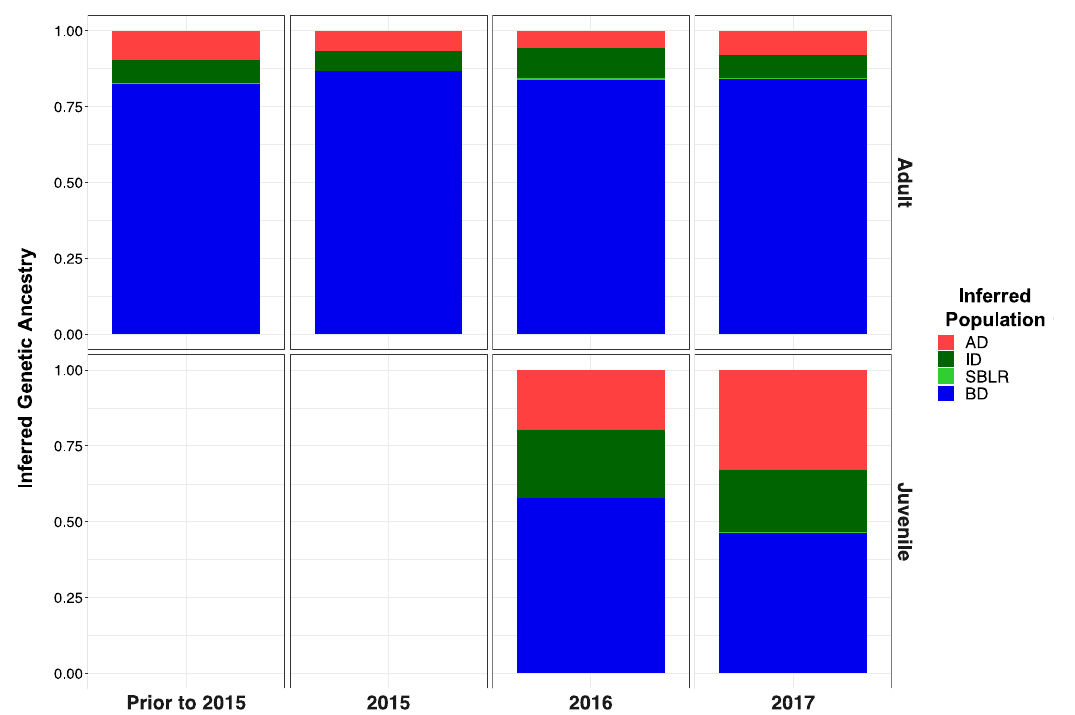
Figure 5. Inferred proportion of genetic ancestry from each of the four reference populations across recolonizing adult steelhead and juvenile smolt life history cohorts. Colors are representative of the inferred population. The bottom x axis divides life history cohorts temporally and the right y axis divides them by life history stage. We included the South Branch of the Little River (SBLR) as a control because we did not expect to see assignment to that population.